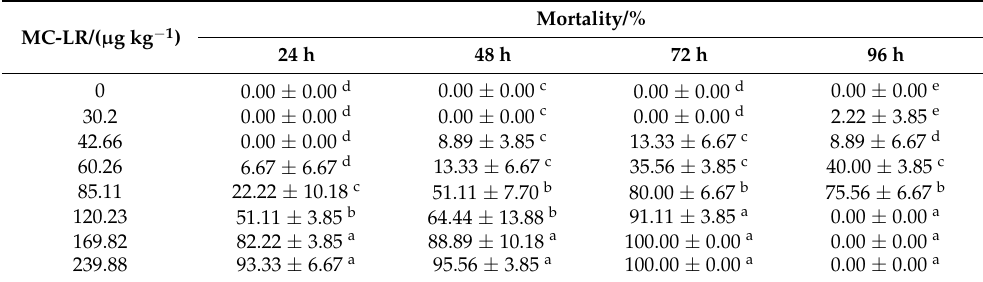
Table 3. The mortality rates of each dose of the pre-experiment at 24, 48, 72, and 96